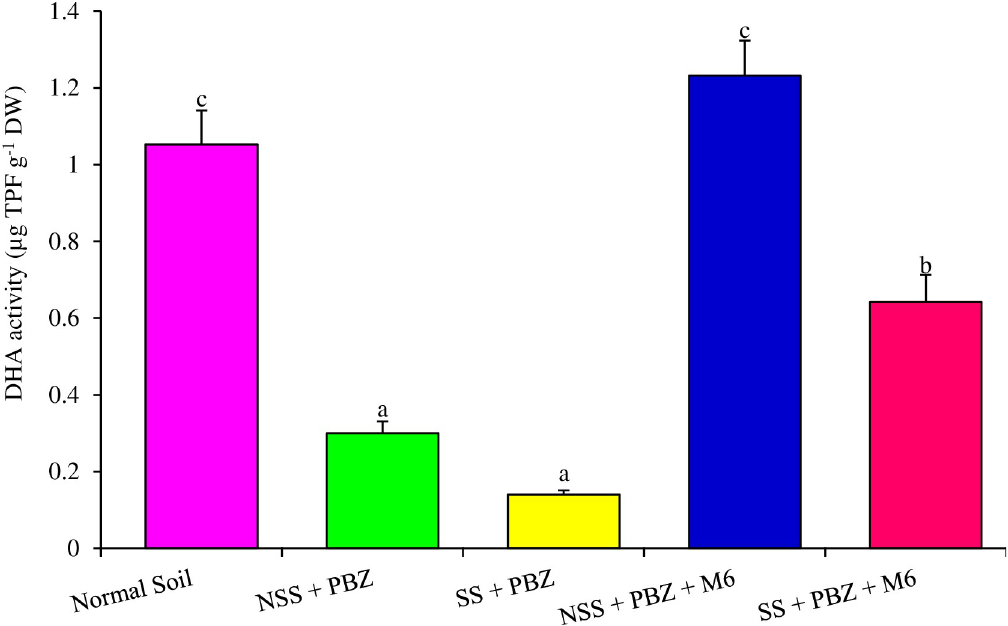
Fig 7. Soil dehydrogenase activity treated with PBZ (NSS-non-sterile soil, SS-sterile